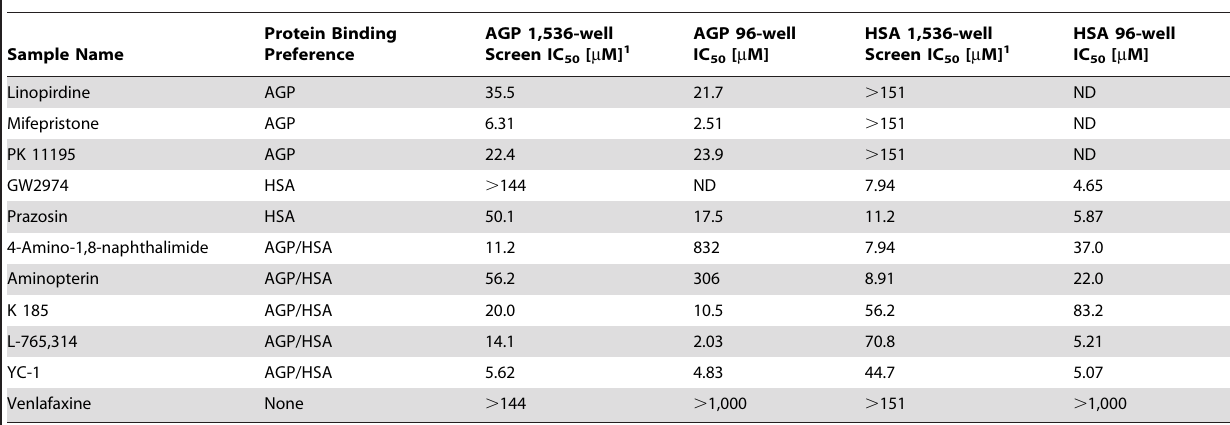
Figure 9. Screen-derived concentration-response curves. Concentration-response profiles of the AGP-selective hit Mifepristone (A), the HSA- selective hit Prazosin (B), and the dual-binder hit YC-1 in the AGP ( doi:10.1371/journal.pone.0045594.g009 We modified our protocol and evaluated the fluorescent probe dipyridamole with AGP in a 384-well format. AGP was titrated (9- Table 4. Top LOPAC 1280